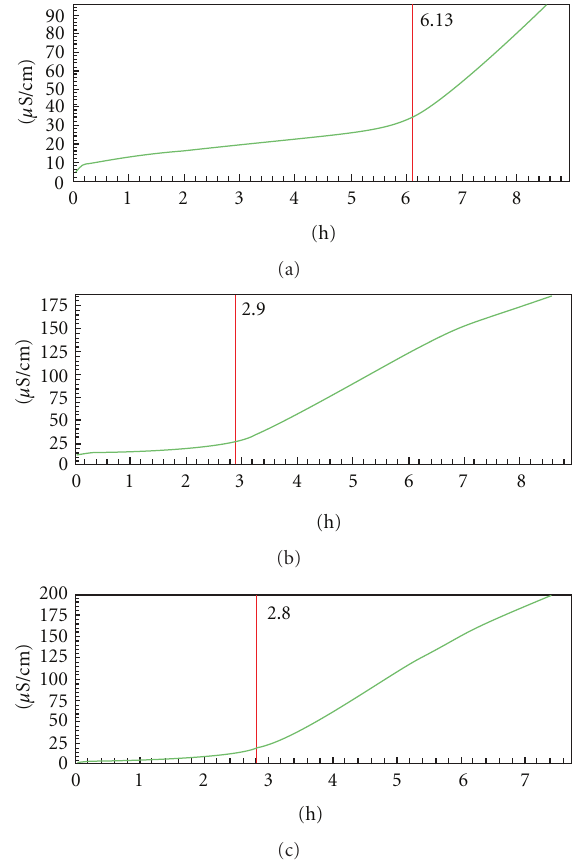
Figure 3: oxidative stability index measurements for: (a) tucum oil, (b) methylic biodiesel, and (c) ethylic biodiesel.